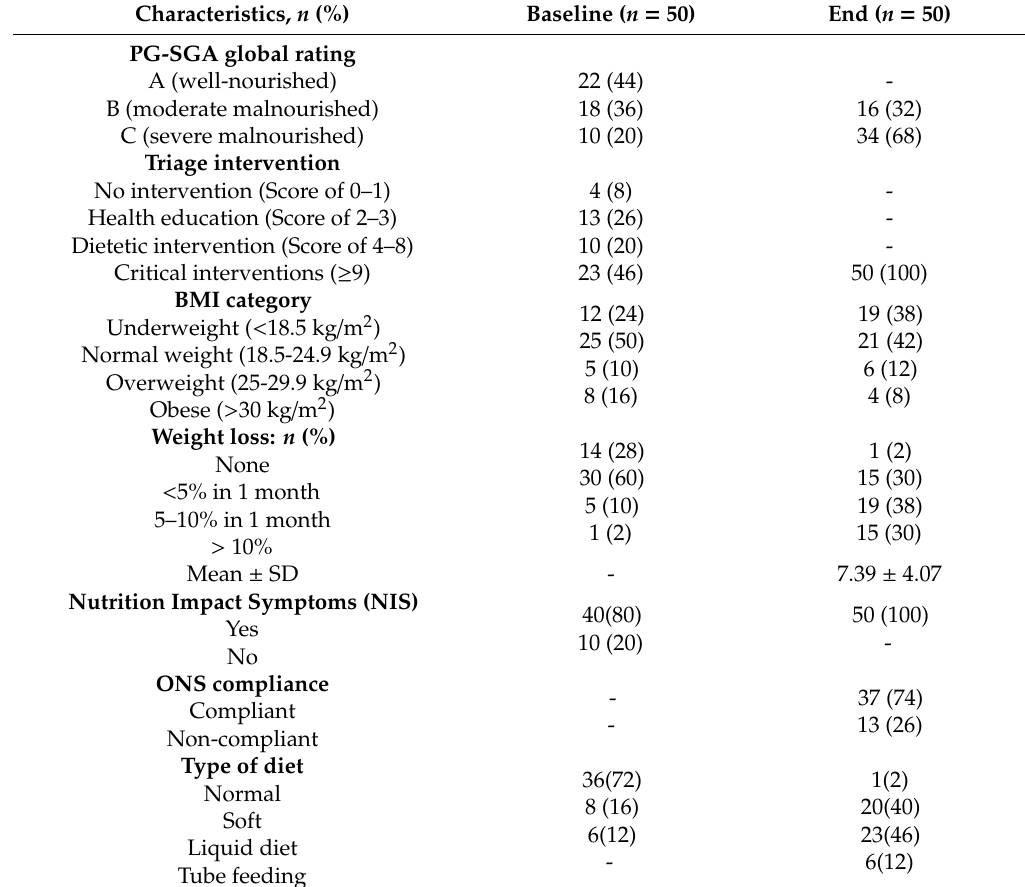
Table 2. Nutritional status, nutrition impact symptoms, ONS compliance, and type of diet at baseline and end of